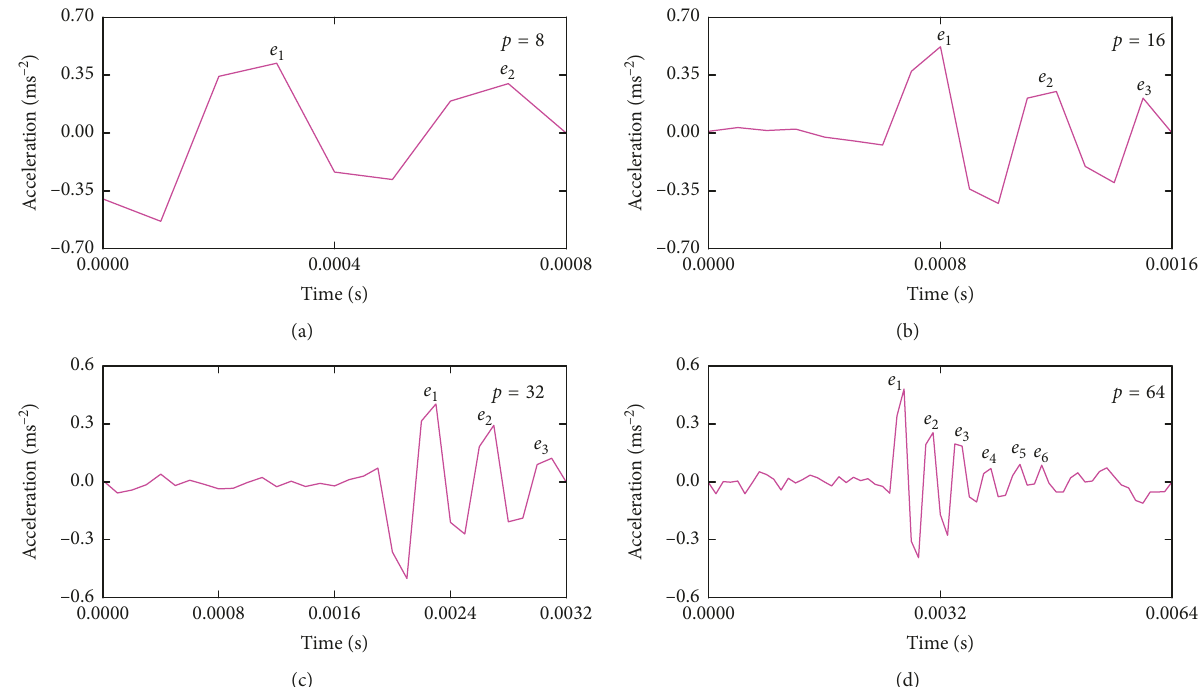
Figure 7: Impulse responses with different lengths P : (a) P � 8; (b) P � 16; (c) P � 32; (d) P � 64.